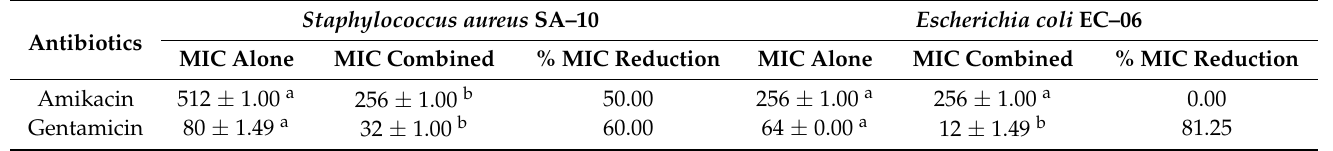
Table 3. Results for the minimum inhibitory concentration—MICs ( µ g/mL) of aminoglycoside antibiotics in the absence and presence of Hancornia speciosa fixed seed